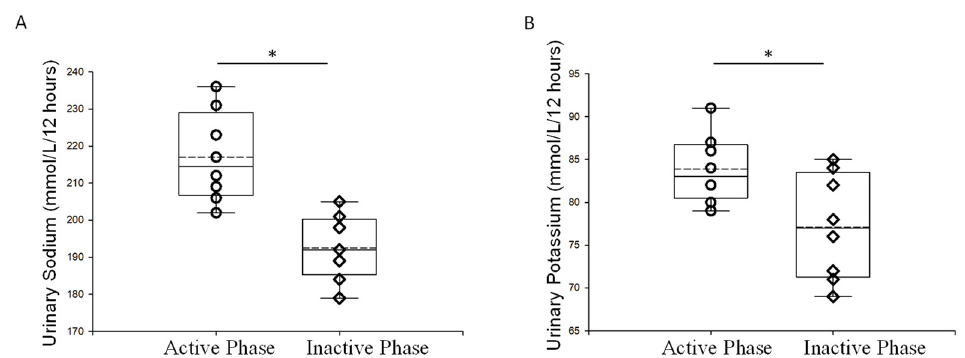
Figure 2. Urinary electrolyte measurements of 18-month old male mice during the inactive and active phases. ( A ) Summary plot of sodium excreted in the urine during the active and inactive phases from aged male mice ( B ) Summary plot of potassium excreted in the urine during the active and inactive phases from aged male mice. A Wilcoxon rank sum test was performed to compare the two groups. n = 7 in each group. The open circles represent individual data points from the AP group and the open triangles represent individual data points from the IP group. * Represents a p -value of ≤